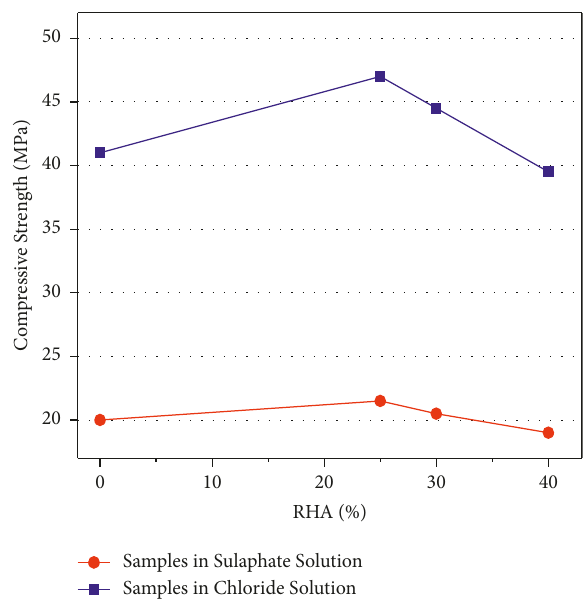
Figure 28: RHA cement mortar in chemical attack